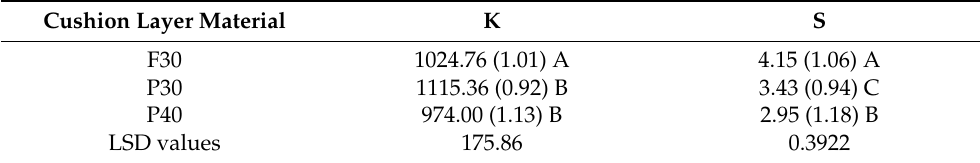
Table 6. The mean hardnesses of the mattresses evaluated in this study (cushion layer).